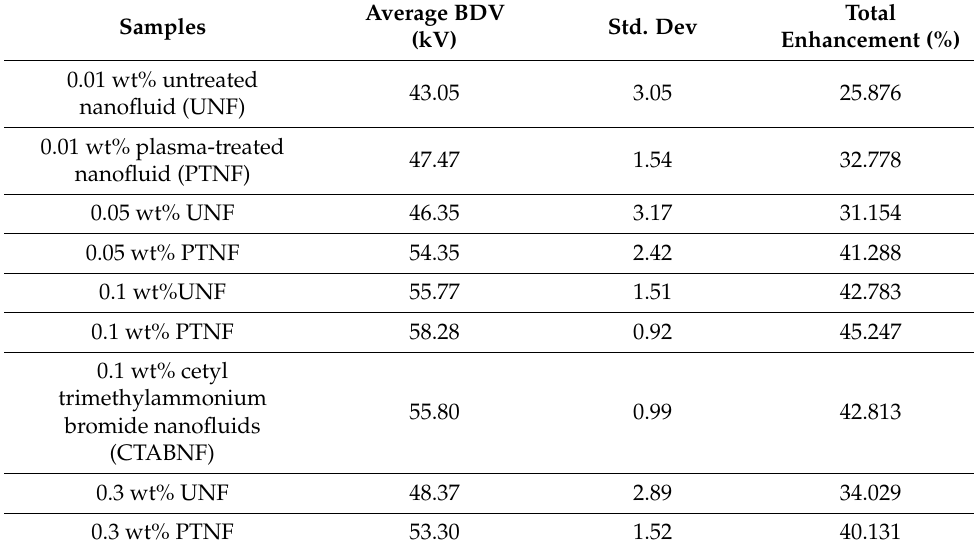
Table 1. Total enhancement of Al 2 O 3 nanofluid samples over pure mineral